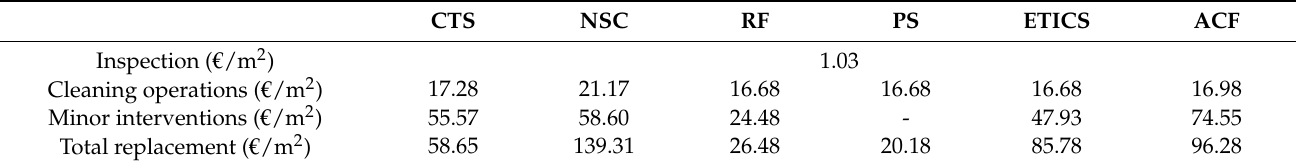
Table 2. Unit costs, at year 0, for the different maintenance activities without the means of access costs. CTS NSC RF PS ETICS ACF Inspection ( € /m 2 ) 1.03 Cleaning operations ( € /m 2